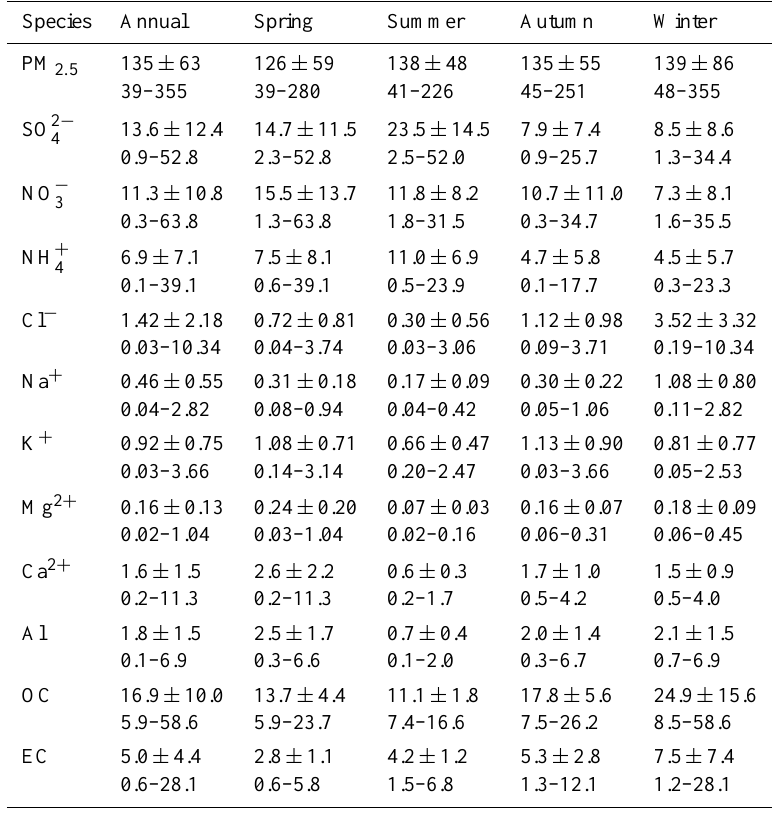
Table 1. Statistical summary showing the means (with one standard deviation) and ranges of atmospheric concentrations for PM 2 . 5 (in